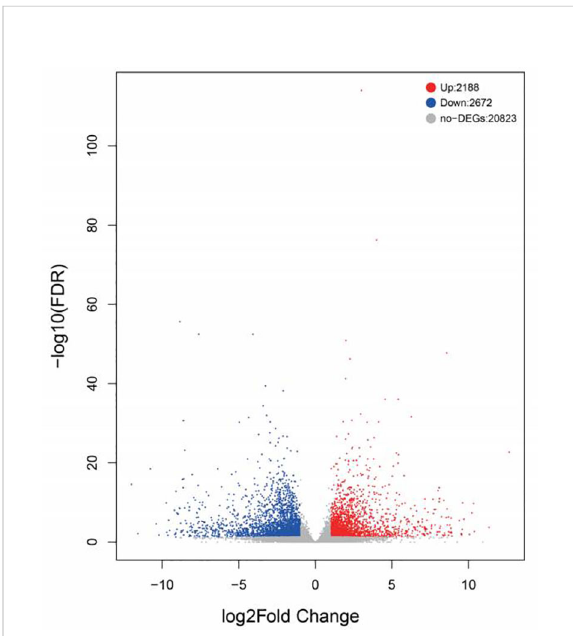
FIGURE 1 Volcano plot of differentially expressed genes identi fi ed between the control and starvation groups. The blue dots represent the down-regulation of gene expression, the red dots represent the up-regulation of gene expression, and the black dots represent the gene with no signi fi cant difference in